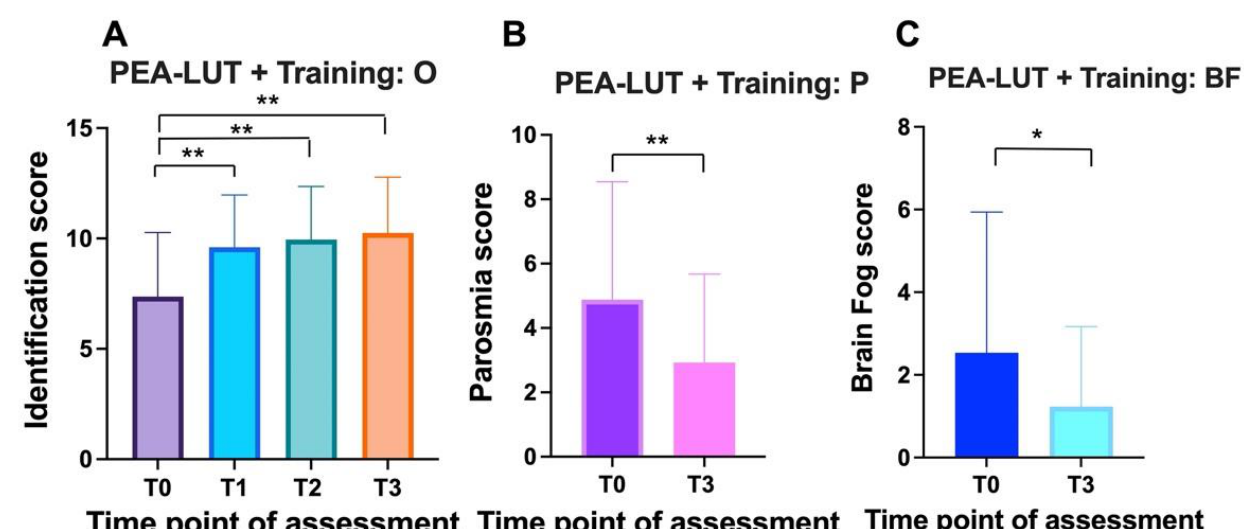
Figure 4. Effect of PEA-LUT treatment plus olfactory training on olfaction, parosmia, and mental clouding in patients without prior olfactory training (Naïve 1 group): ( A ) O (olfaction) results of identification test at T0 (baseline), T1 (1 month), T2 (2 months) and T3 (3 months); ( B ) P (parosmia) before (T0) and after three months (T3) of treatment; ( C ) BF (brain fog/mental clouding) before (T0) and after three months (T3) of treatment. **: p < 0.01; *: p < 0.05.